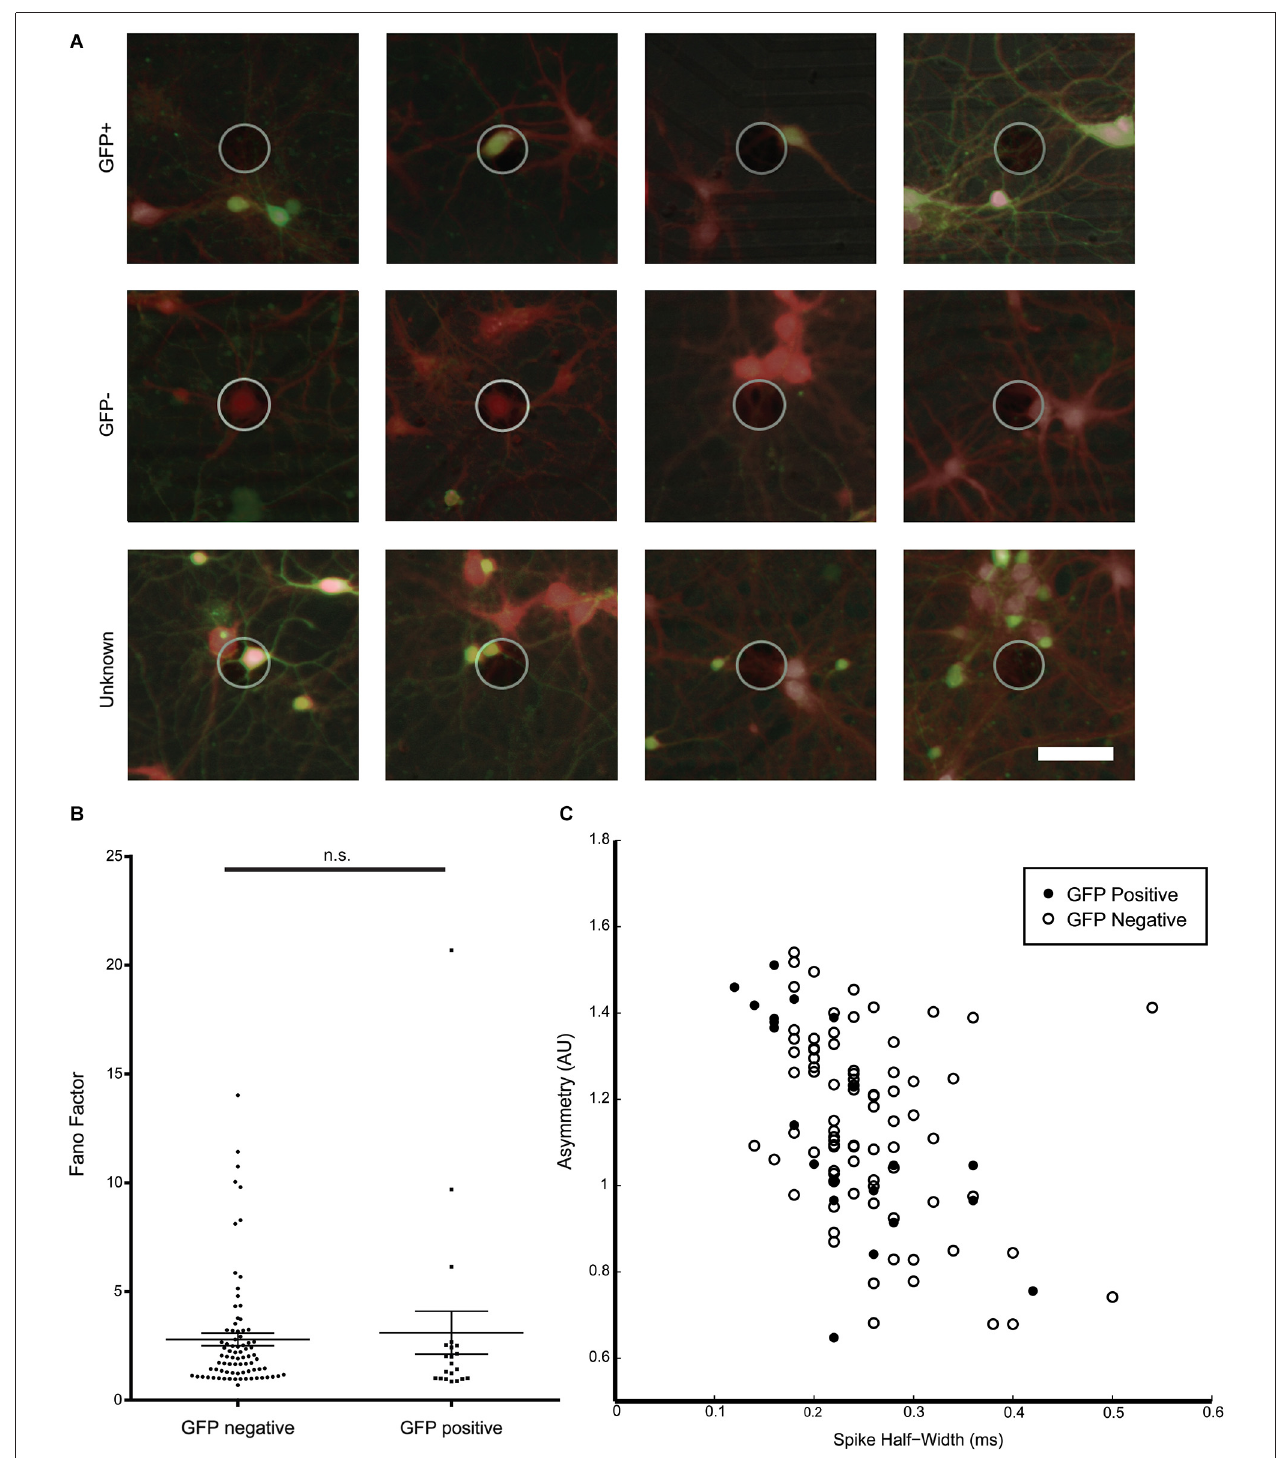
assigned to a GFP-negative neuron. Bottom row: spikes cannot be clearly assigned to GFP-positive or GFP-negative neurons. (B) No significant difference between Fano Factors for GFP-positive and GFP-negative neurons. (C) Cluster analysis of spike asymmetry vs. half-width. Filled circles are GFP-positive neurons, open circles are GFP-negative